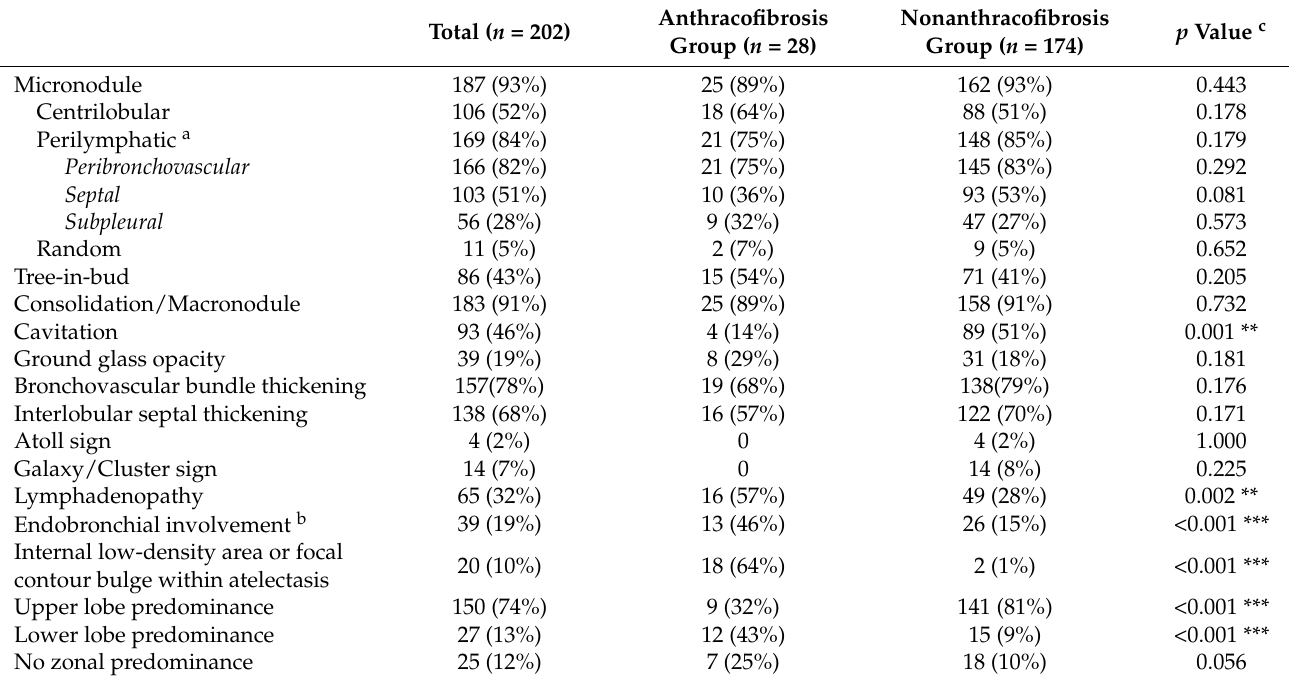
Table 2. The frequency of CT findings and statistical differences between anthracofibrosis group and nonanthracofibrosis